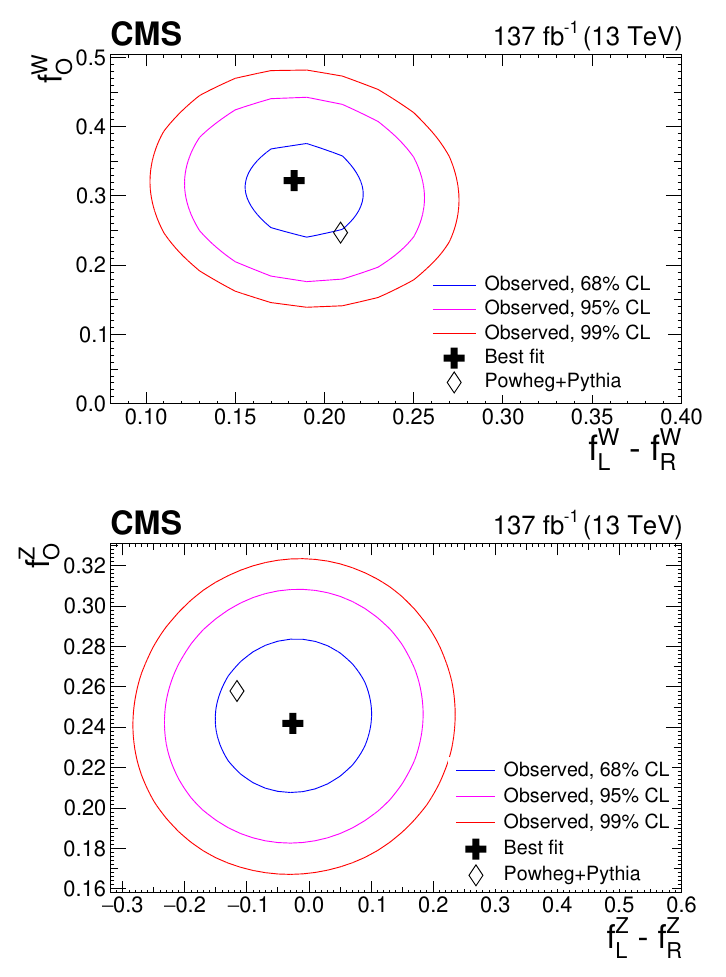
– f parameter plane for the W (top) and Z (bottom) LR 0